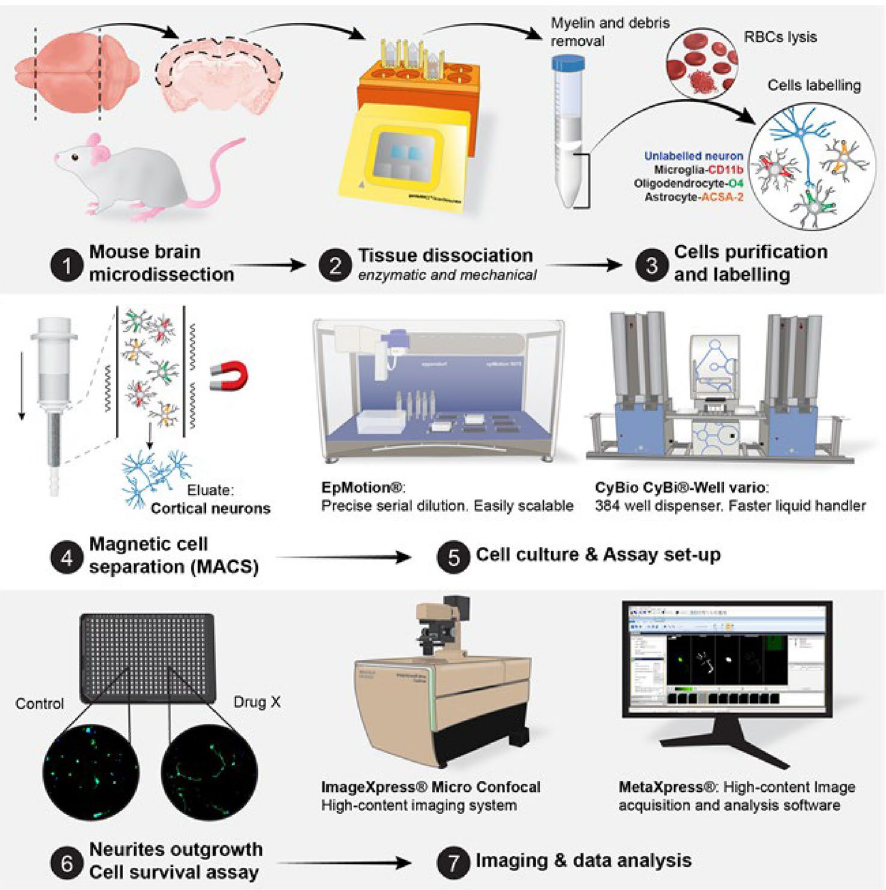
Figure 8. The screening platform using primary adult neural cells. Briefly, the cortex is extracted from mice, dissociated in a dissociator, followed by the removal of debris and red blood cells. Afterwards, the glial cells are separated from neurons. All liquid handling, imaging, and analysis is done with bias and human free robots. Figure was created by Graphit Science & Art,